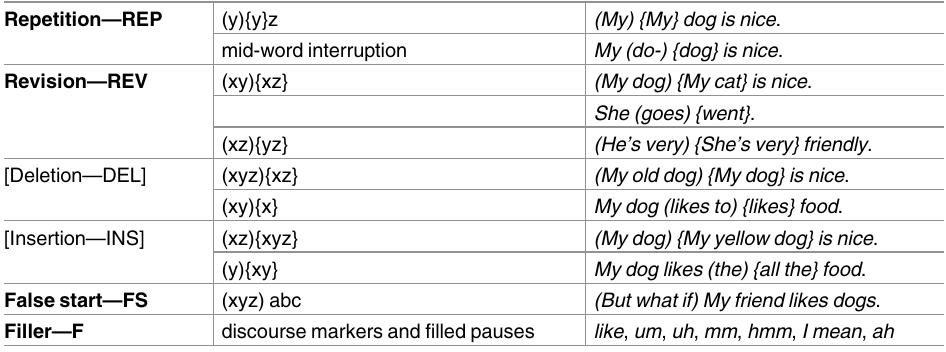
Table 1. Disfluency type